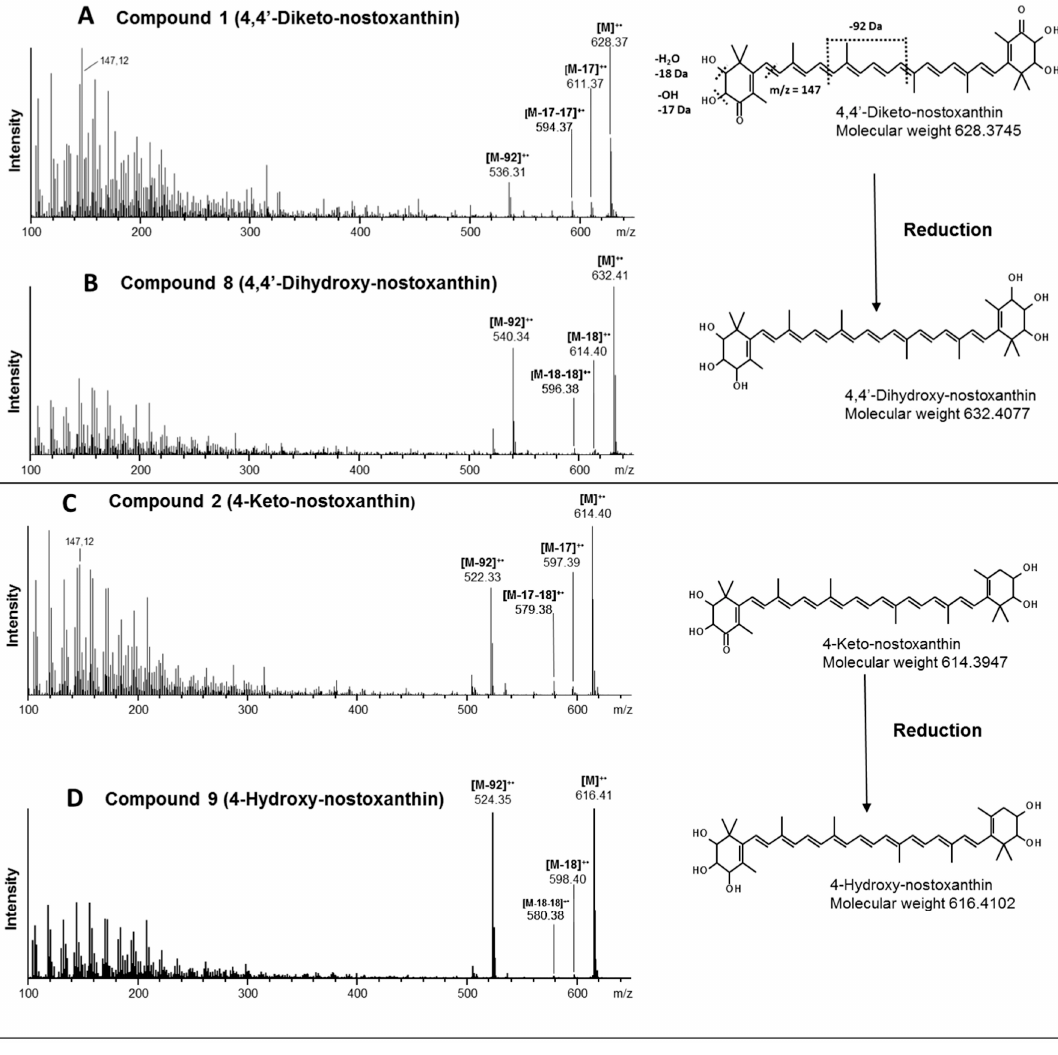
Figure 5. ( A – D ) MS-MS analysis of de-novo generated hydroxyl and keto-hydroxy β -carotene derivatives before and after reduction. The structures are indicated including the fragmentation pattern exemplified for 4-keto-nostoxanthin. Table 2. Overview of identified multi-oxygenated nostoxanthins using UPLC-ESI-HRMS. Compound